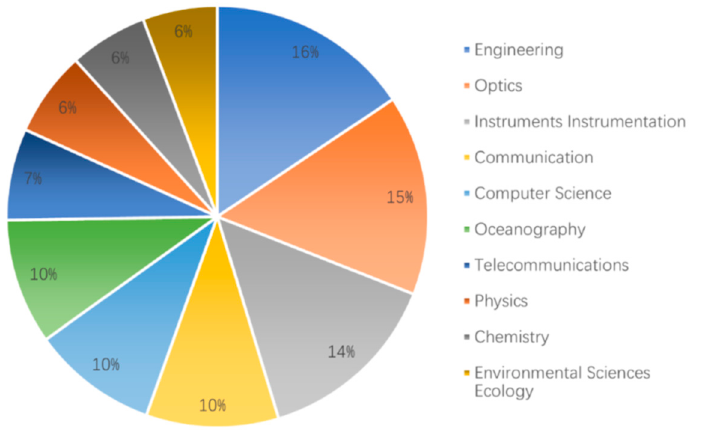
Figure 1. Percentages of different application areas.